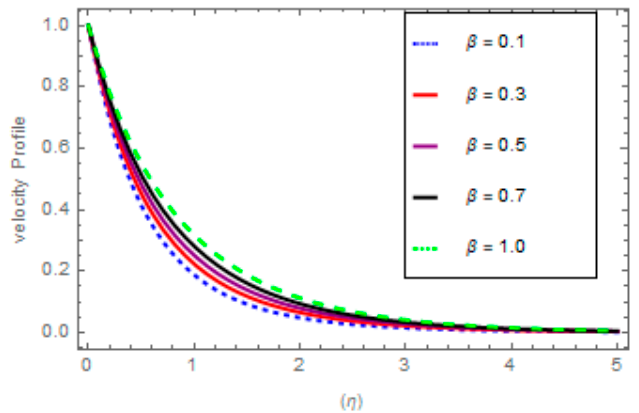
( ) ' u η ( ) 0 ( η ) . Figure 2. Upshot of β on ' . u η 0 β 0 on .